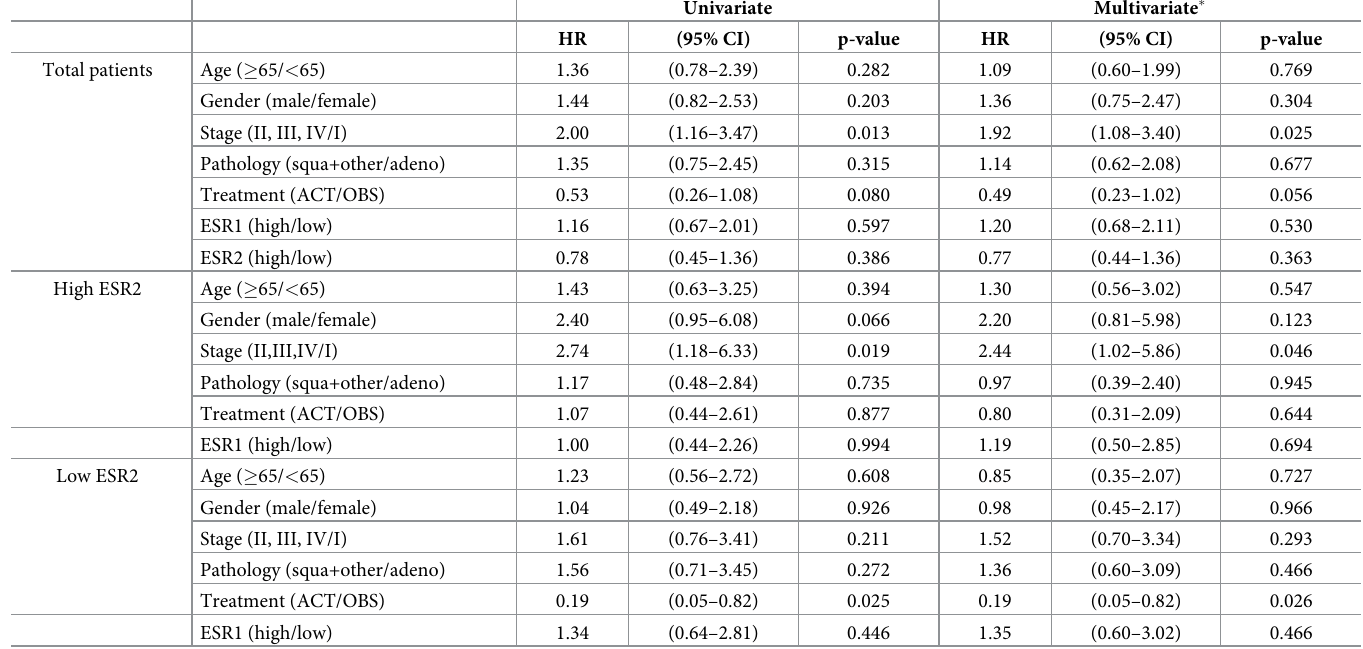
Table 2. Results of both univariate and multivariate cox regression analyses for total patients and subgroups with low and high ESR2 expression in the discovery